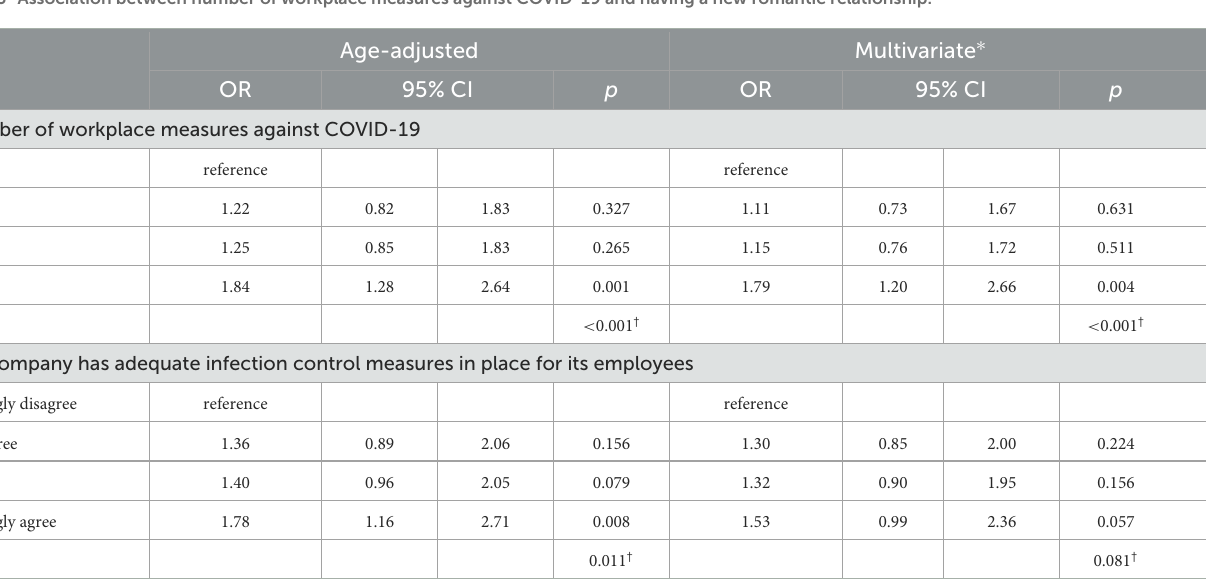
TABLE 3 Association between number of workplace measures against COVID-19 and having a new romantic